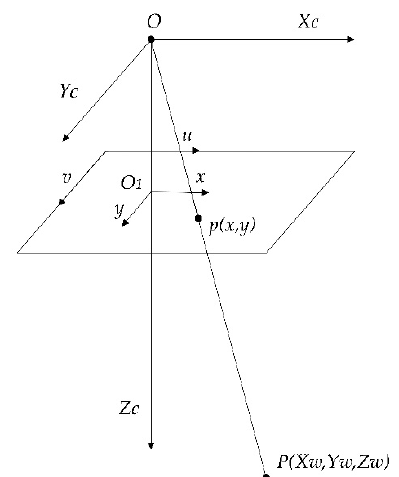
Figure 5. Monocular camera pinhole